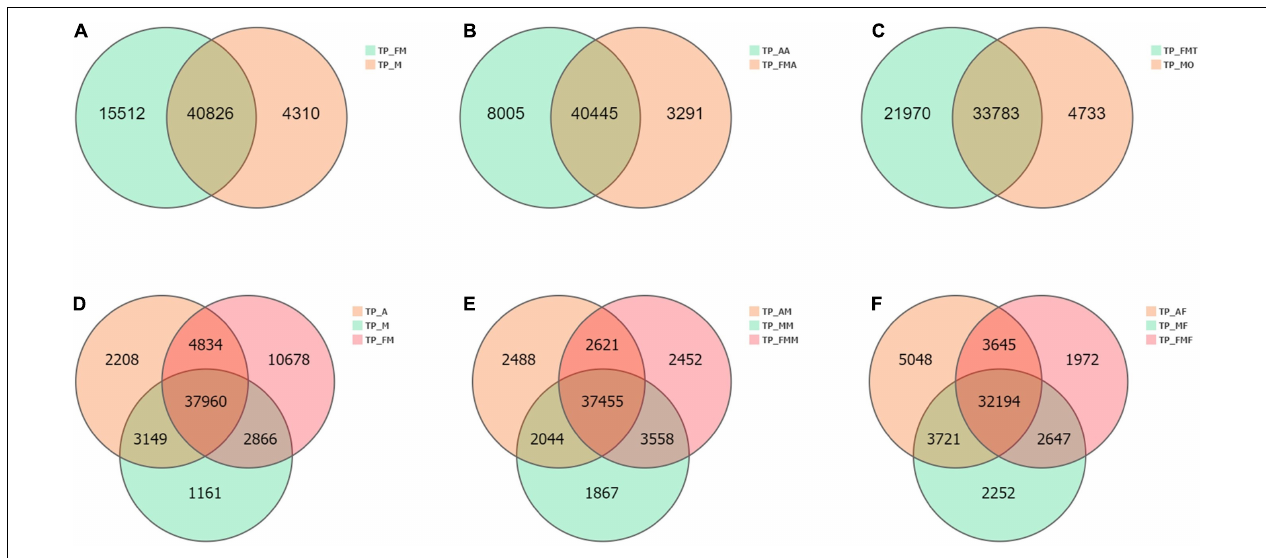
FIGURE 3 | Venn diagram of the number of differential genes between different tissue samples. (A) Comparative analysis of female (TP_FM) and male adult (TP_FM). (B) Comparative analysis of nymph antennae (TP_AA) and adult antennae (TP_FMA). (C) Comparative analysis of ovaries (TP_MO) and testis (TP_FMT).